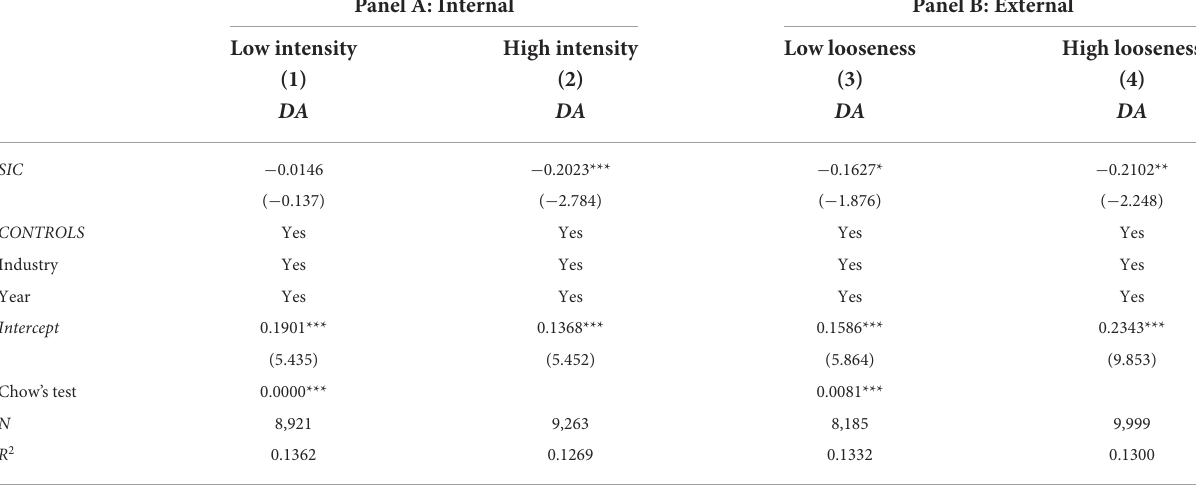
TABLE 5A Internal and external social insurance